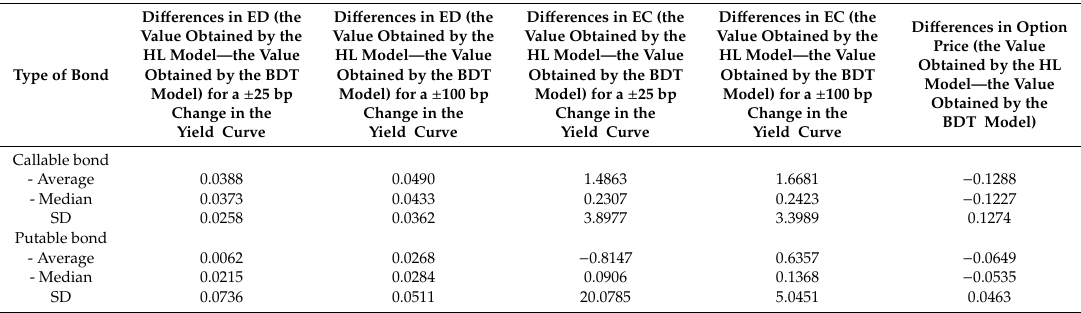
Table 2. Di ff erences between the HL and BDT models in terms of ED, EC, and option price. These di ff erences were calculated as the value of the variable obtained using the HL model minus the value of the variable obtained using the BDT model.